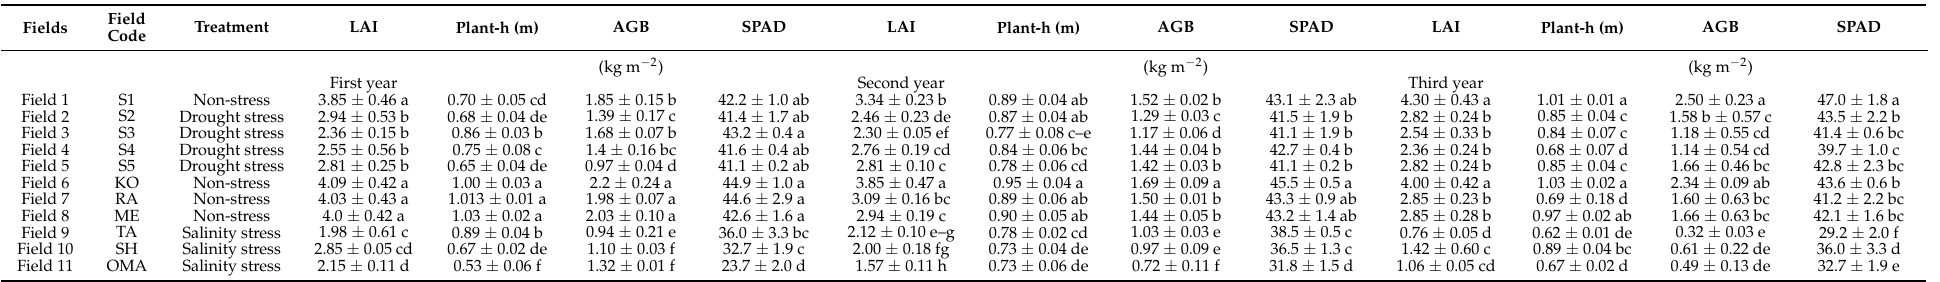
Table 3. Mean and standard deviation (SD) of LAI, plant height (plant-h), above ground biomass (AGB) and SPAD value of wheat crops in three years across the study